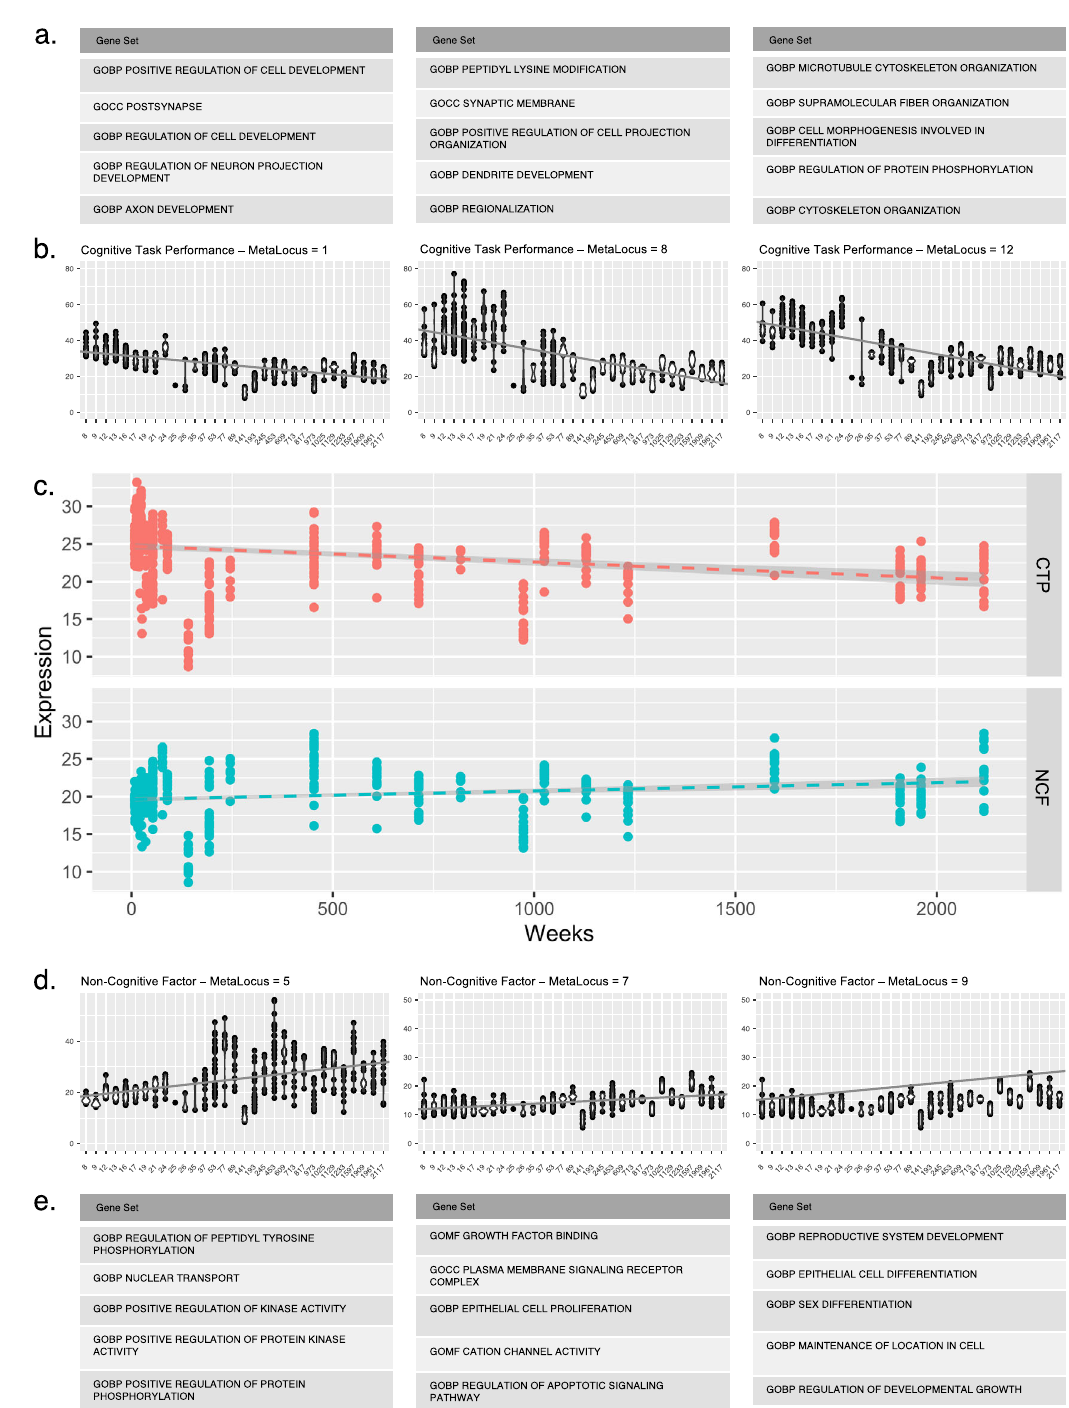
Fig. 5 | Temporal gene expression within prenatal cognitive task performance and adulthood non-cognitive factor meta-loci. CTP cognitive task performance. NCF non-cognitive factor. a Top cognitive task performance gene sets for each indicatedmeta-locus b meta-loci showing signi fi cant trajectories forprenatal gene expression implicating cognitive task performance c aggregated temporal gene